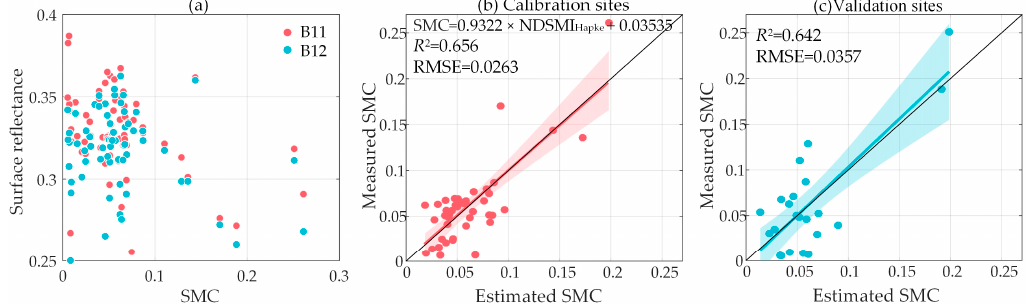
Figure 17. ( a ) Sentinel-2 MSI B11 (1610 nm) and B12 (2185 nm) vs SMC. ( b ) SMC estimated and measured by using NDSMI Hapke (calibration sites). ( c ) SMC estimated and measured by using NDSMI Hapke (validation